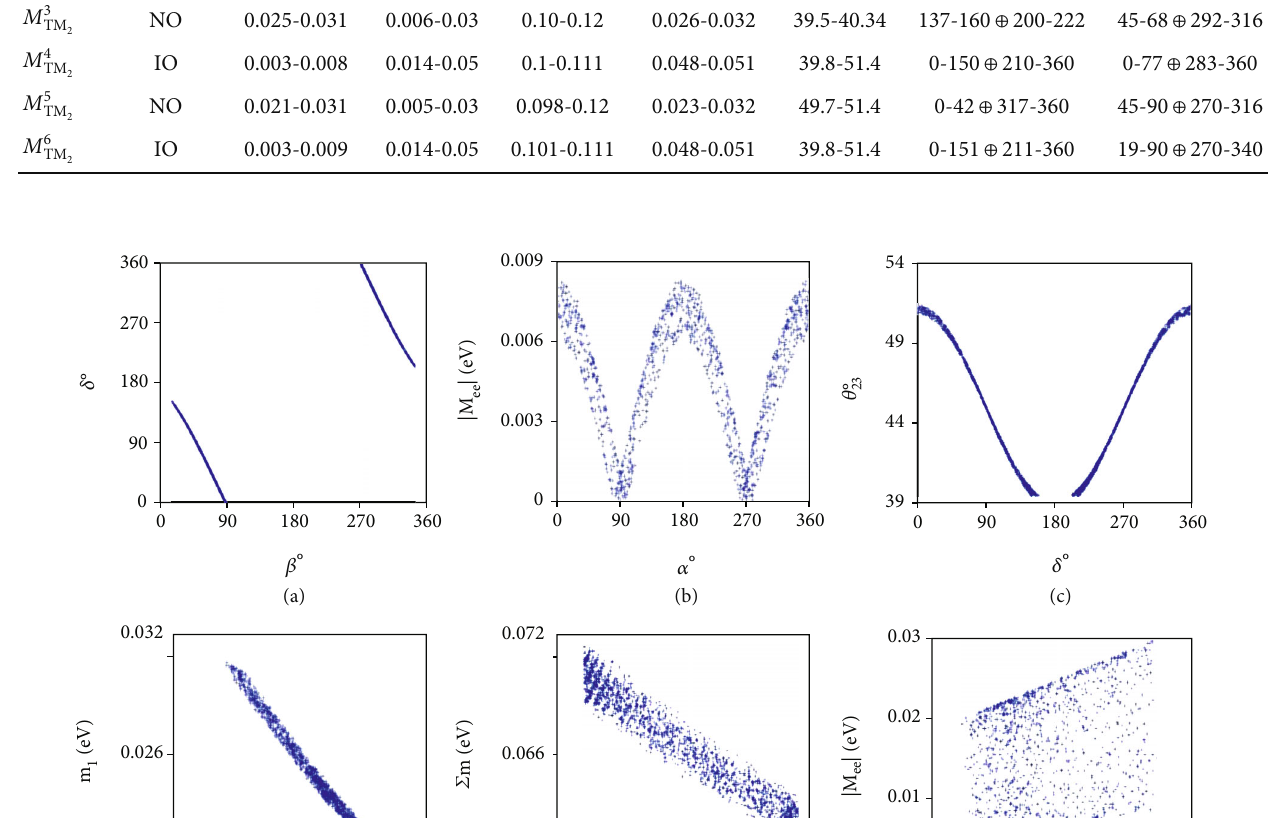
, (b) M 1 , (c) M 2 , (d) M 5 , (e) M 2 , (f) M 5 , (g) M 1 , TM 2 TM 2 TM 2 TM 2 TM 2 TM 2 TM 2